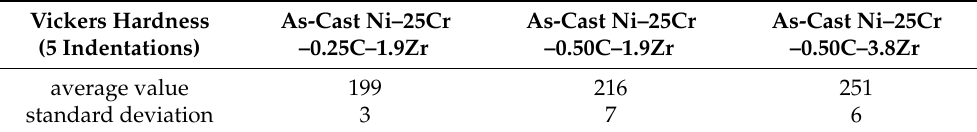
Table 3. Vickers macro hardness of the Zr–containing